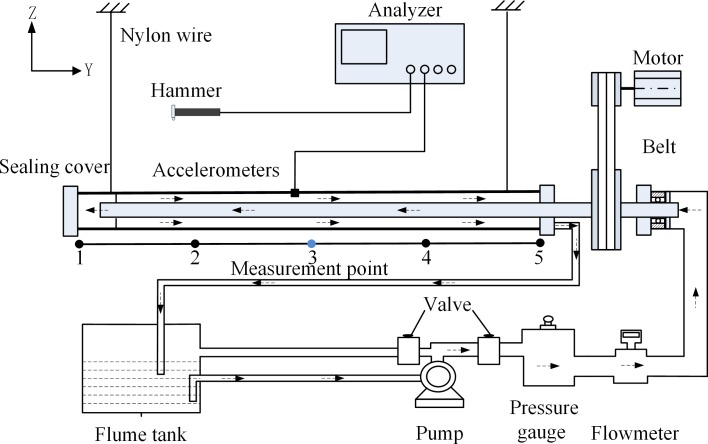
Experimental scheme.